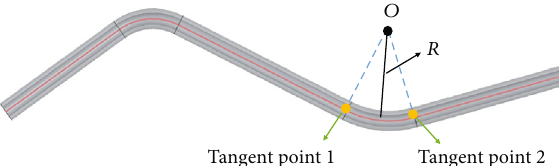
Figure 5: Bending radius of